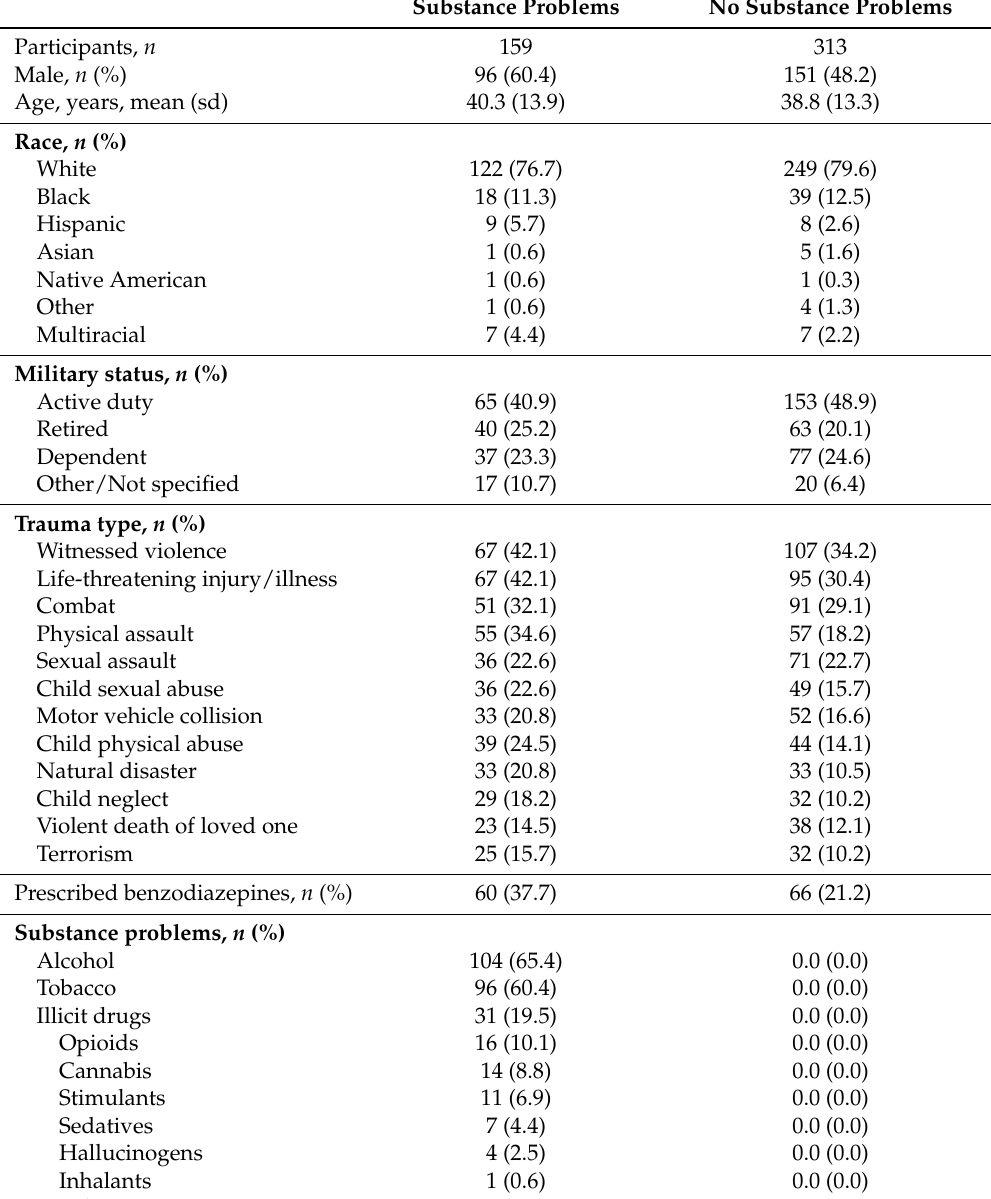
Table 1. Participant characteristics, by history of substance-related